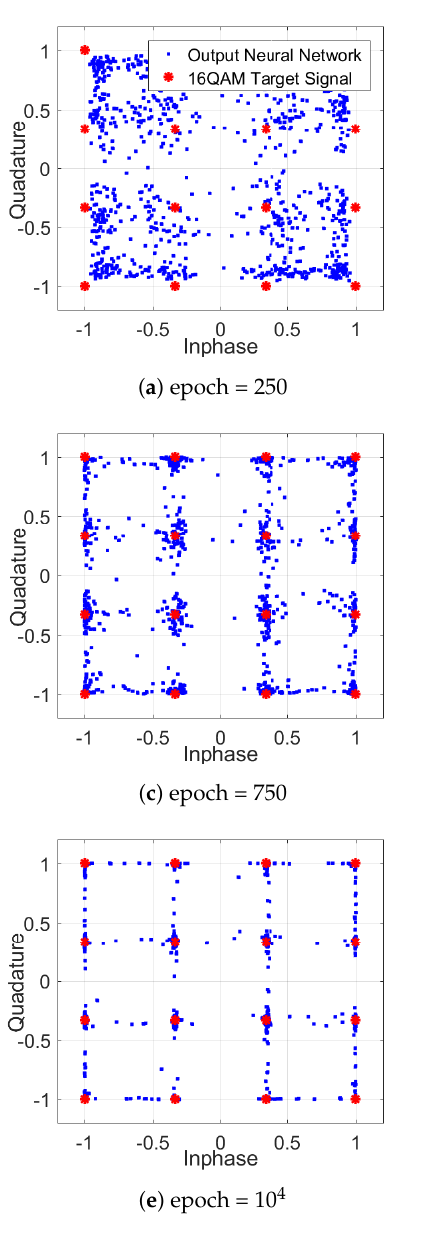
Figure 11. Constellation diagrams during the learning